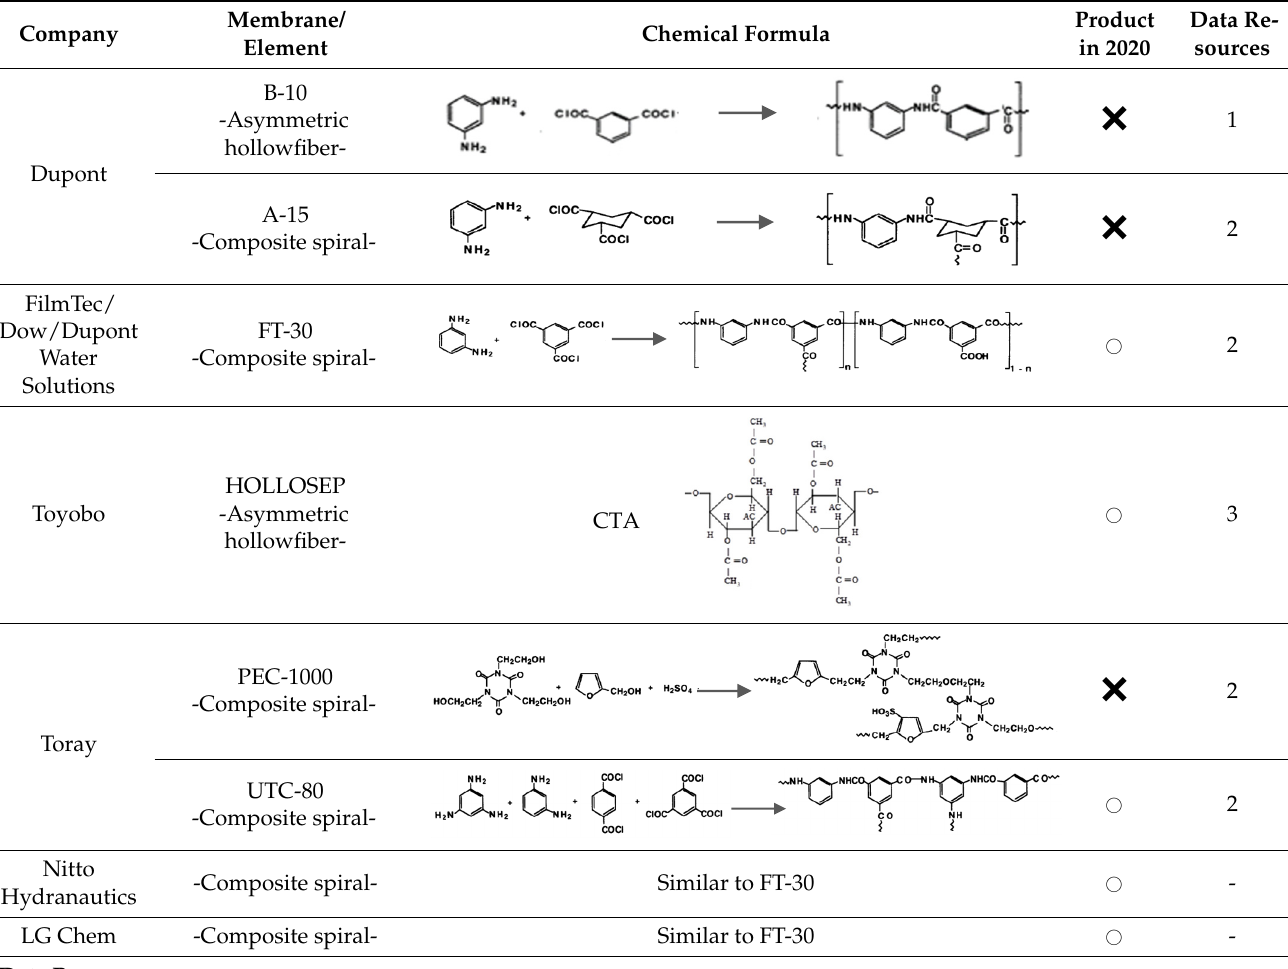
Table 1. Commercial SWRO membrane material and